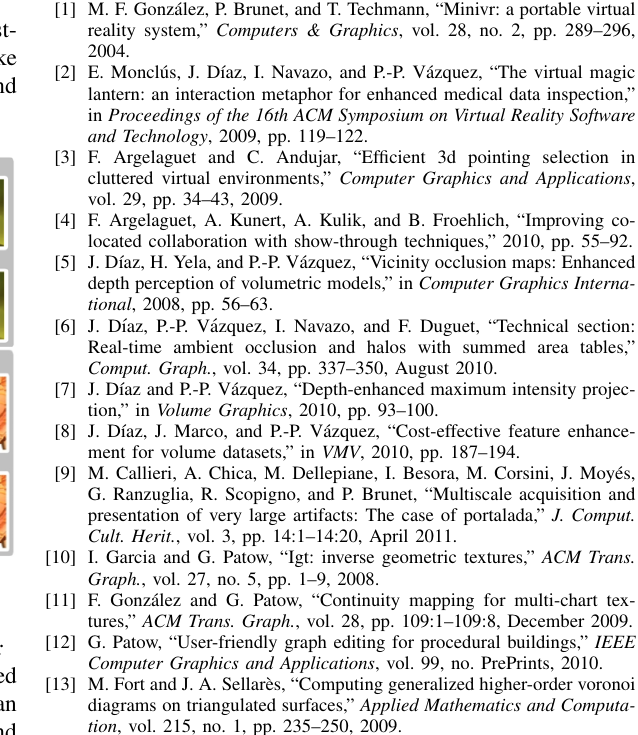
Fig. 5. Inverse Geometric Textures